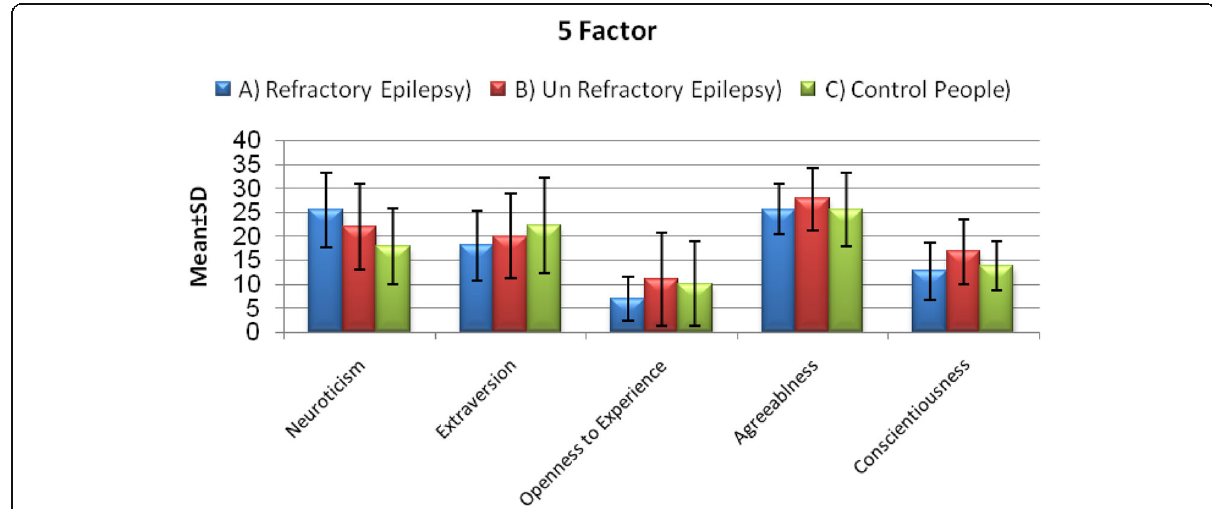
Fig. 1 Comparison between the studied sample groups regarding five-factor